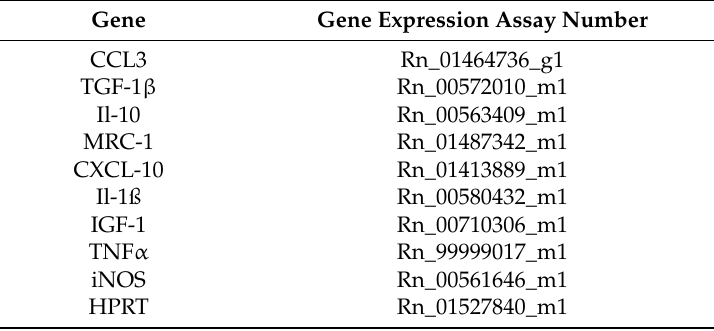
Table 1. Primer used for polymerase chain